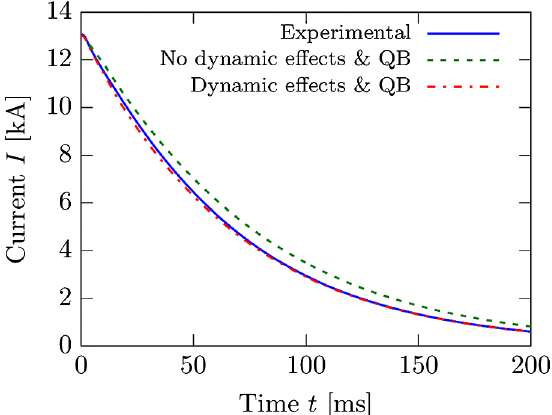
FIG. 4. Comparison between the experimental current decay (solid blue curve), a QLASA simulation which considers dy- namic effects on the inductance due to IFCCs and quench back after 10 ms (point-dashed red curve), and a standard QLASA simulation without considering dynamic effects but considering quench back after 10 ms (dashed green